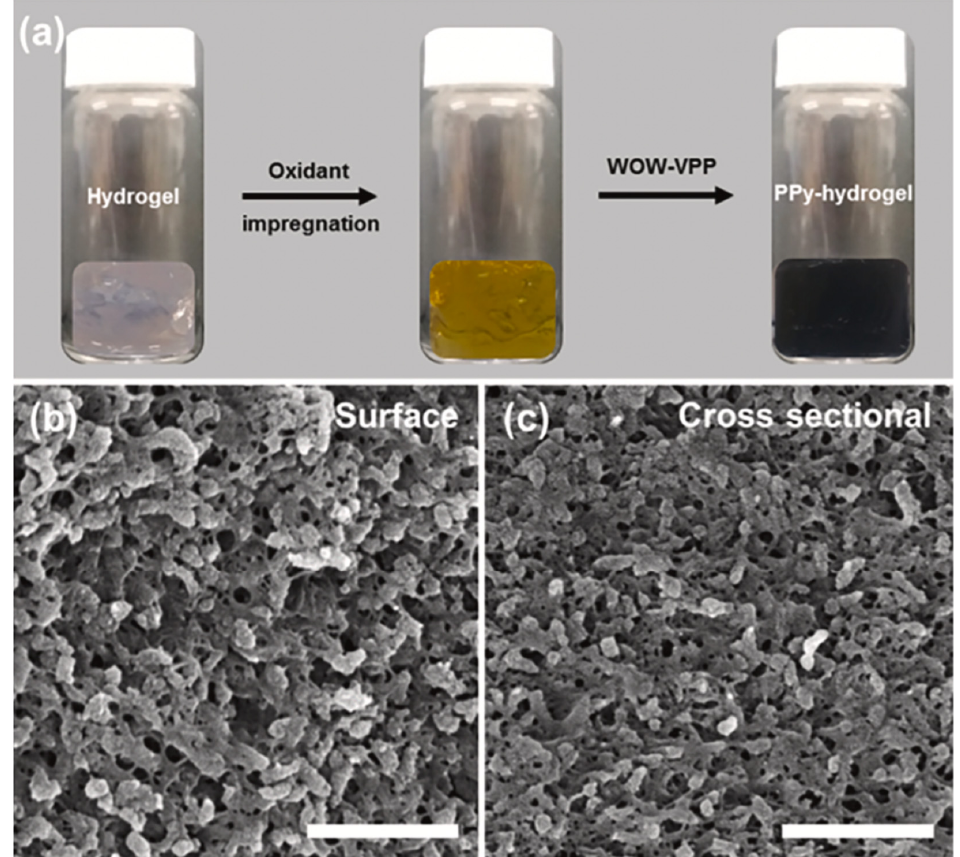
Figure 8. ( a ) Hydrogen of PPy coated on CNC, ( b ) SEM image of the hydrogel surface and ( c ) cross- sectional image of the hydrogel. Reproduced from ref. [98].